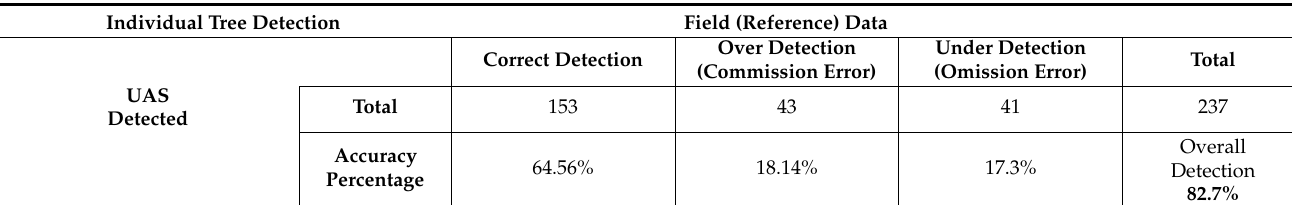
Table 3. Individual tree detection (ITD) accuracy, including the rates of commission and omission error as well as the overall detection accuracy.